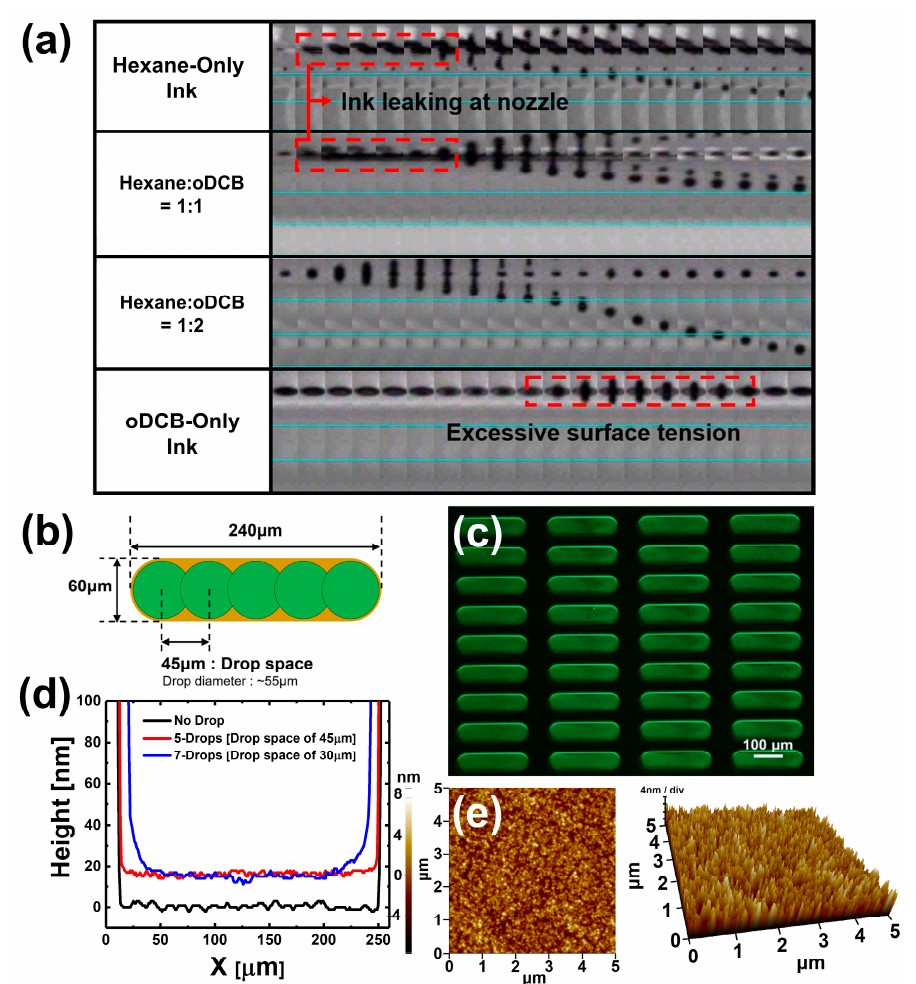
Figure 3. ( a ) Ink-jetting motion capture for each cosolvent condition. ( b ) Bank pixel information and 5-drop space conditions. ( c ) OM images with UV light of QD EML pixels. ( d ) Height profile of the QD EML by ink-jet printing of cosolvents QDs ink of hexane and oDCB with ratio of 1:2 under 5-drop and 7-drop space conditions. ( e ) AFM images of the QD EML pixel surface. Surface roughness RMS value was measured 1.59 nm.